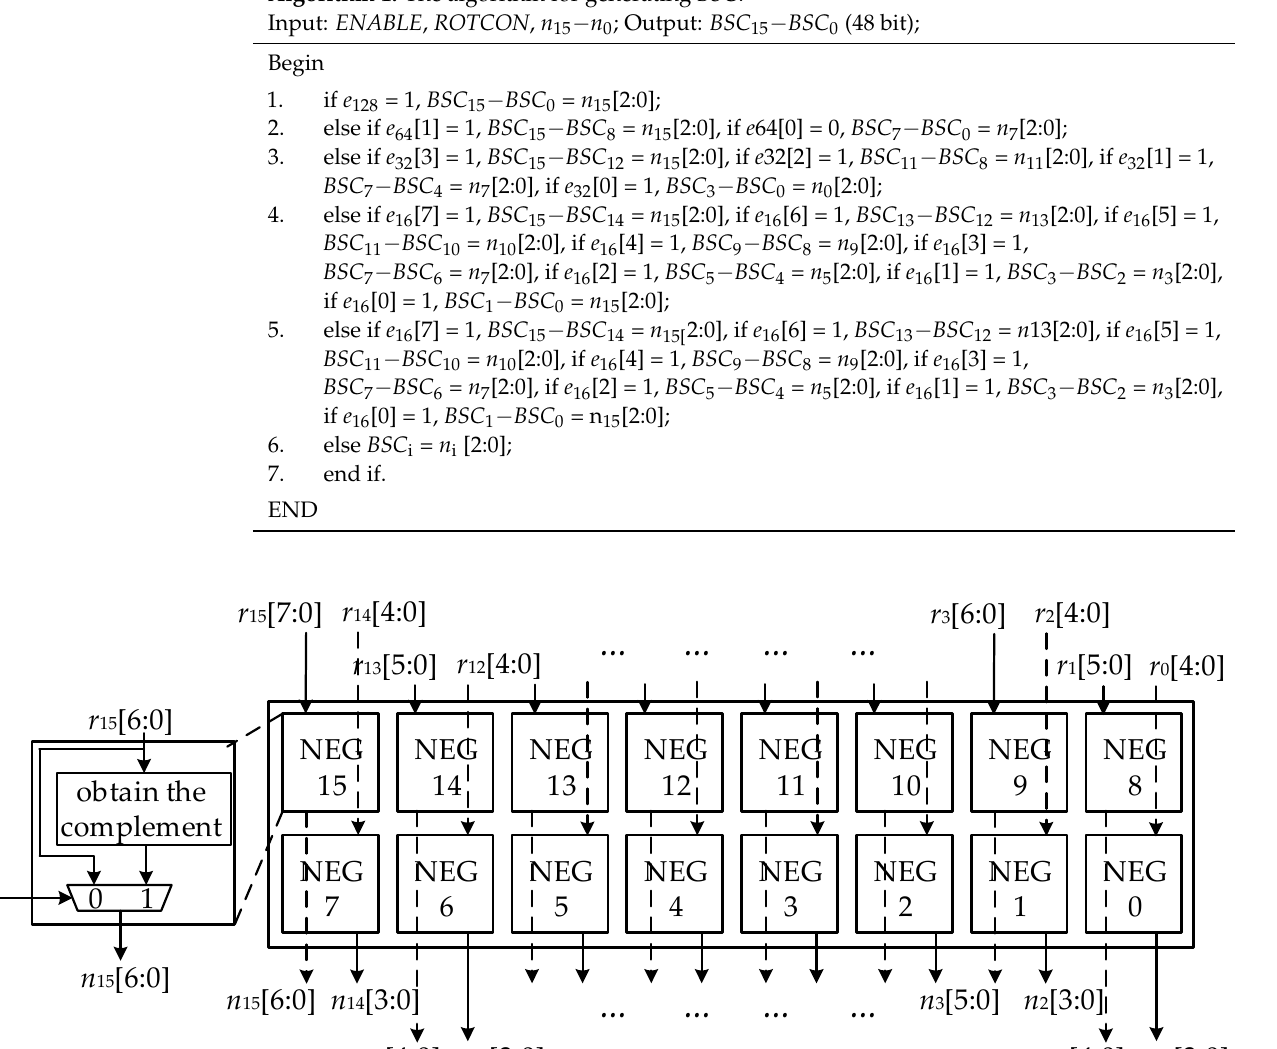
Algorithm 1: The algorithm for generating BSC .